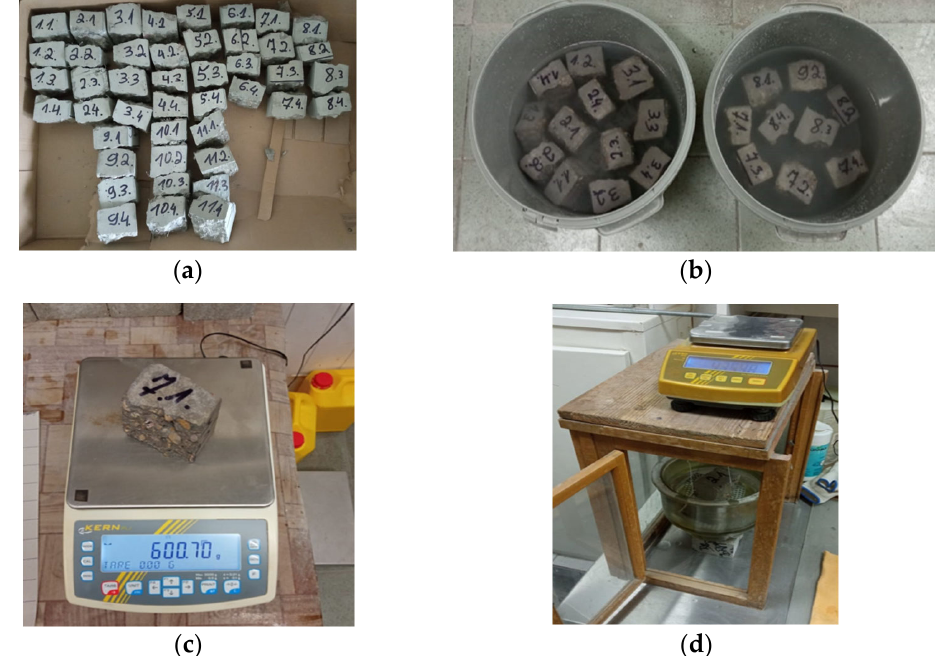
Figure 3. Images of measuring the kinetics for water adsorption; ( a ) dry specimens; ( b ) wet specimens; ( c ) specimen weight measurement; ( d ) specimen weight measurement in water.